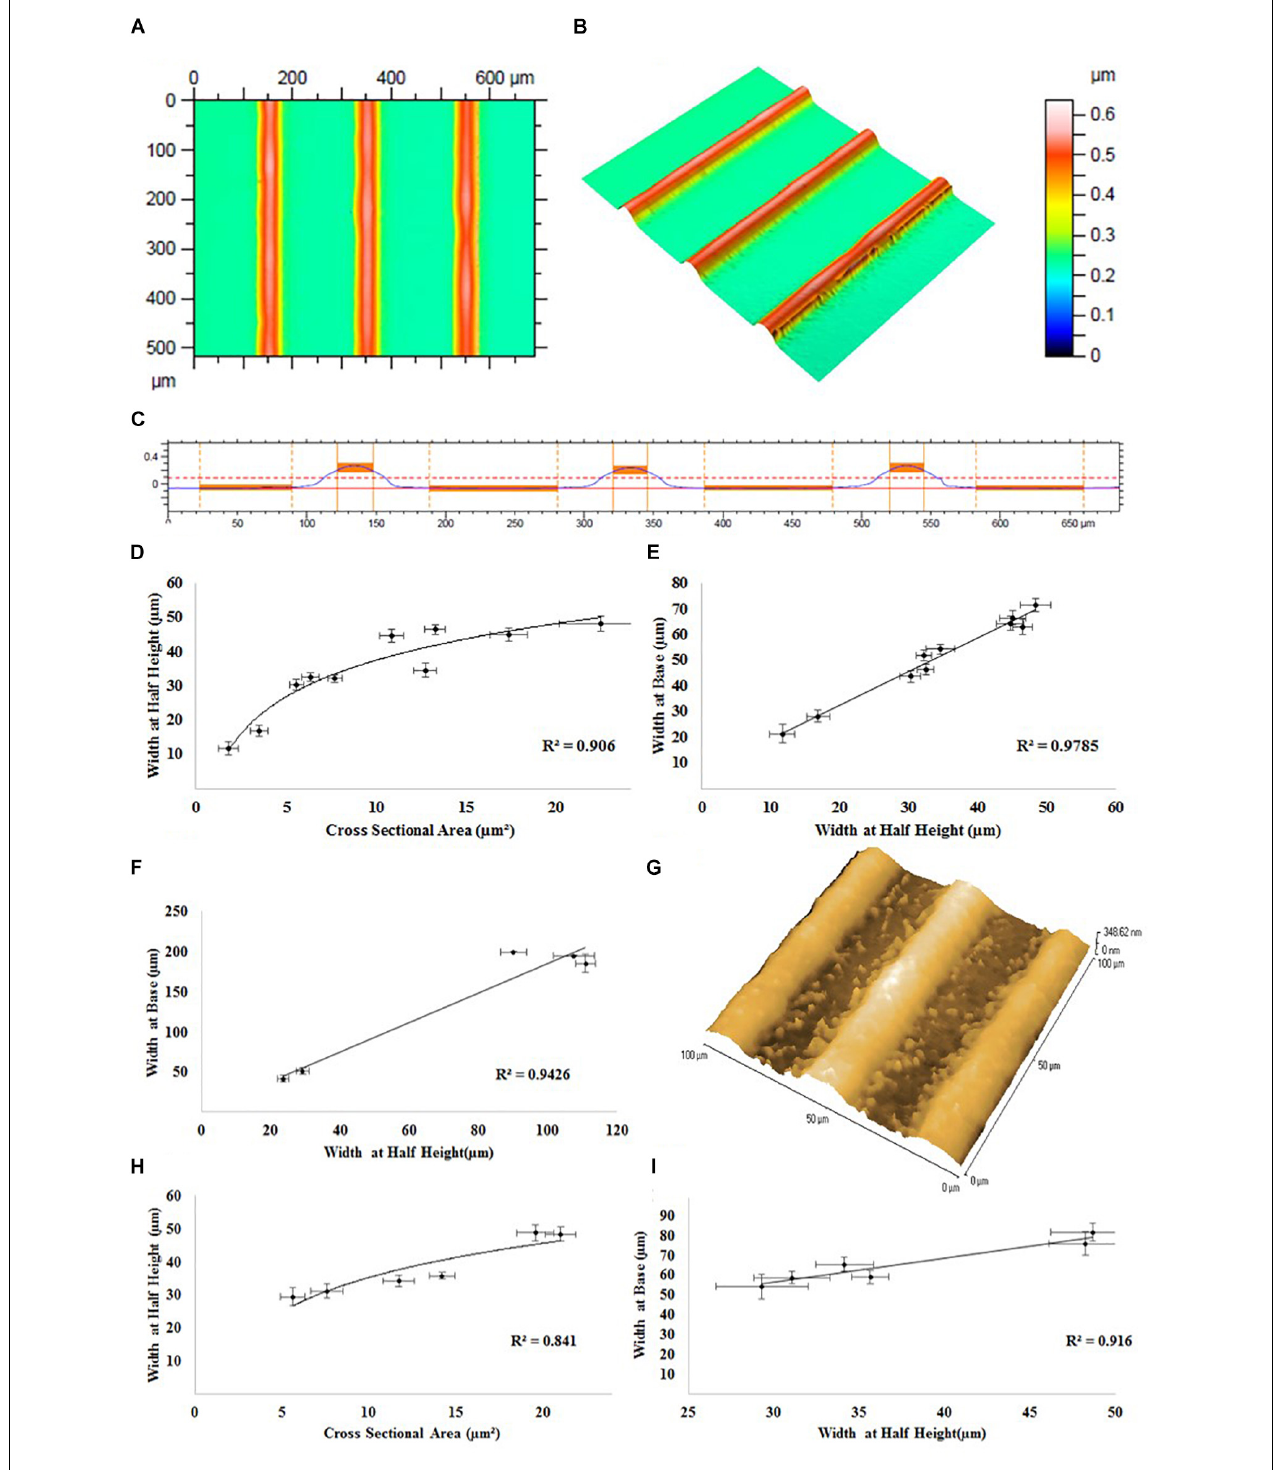
FIGURE 3 | Representative white light interferometry measurements of PEDOT:PSS tracks on a glass substrate: (A) 2D top down graphical representation, (B) 3D graphical representation, and (C) 2D cross sectional graphical representation of a track profile. (D) Track width at half height vs. track cross sectional area. (E) Track width at half height vs. track width at base. (F) Atomic force microscopy measurements of PEDOT:PSS tracks on a glass substrate. (G) A representative AFM image of the surface of the tracks. White light interferometry measurements of PEDOT:PSS tracks on a PKSPMA coated glass substrate. (H) Track width at half height vs. track cross sectional area. (I) Track width at half height vs. track width at base.